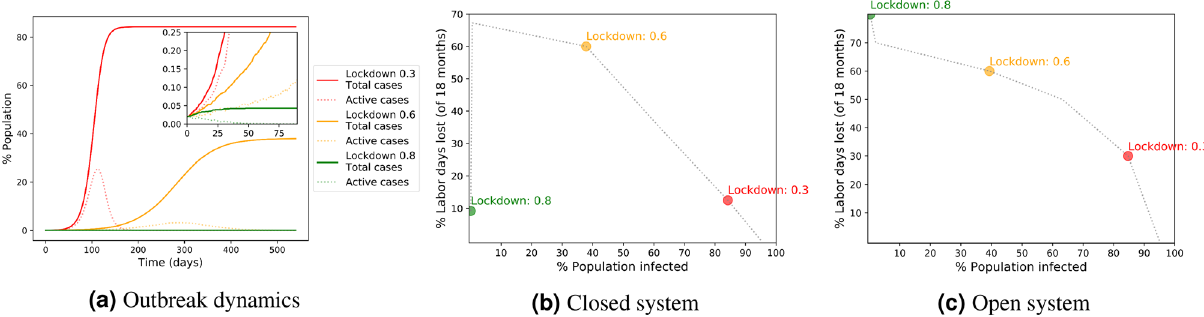
Figure 1. Outbreak dynamics and outcomes with different lockdown levels. (a) Outbreak dynamics. The full and dotted lines show the total percentage of population infected and the percentage of active cases, respectively, as a function of time. (b,c) The cost map of the percentage of labor days lost in a period of 18 months versus the percentage of population infected, in closed and open systems,